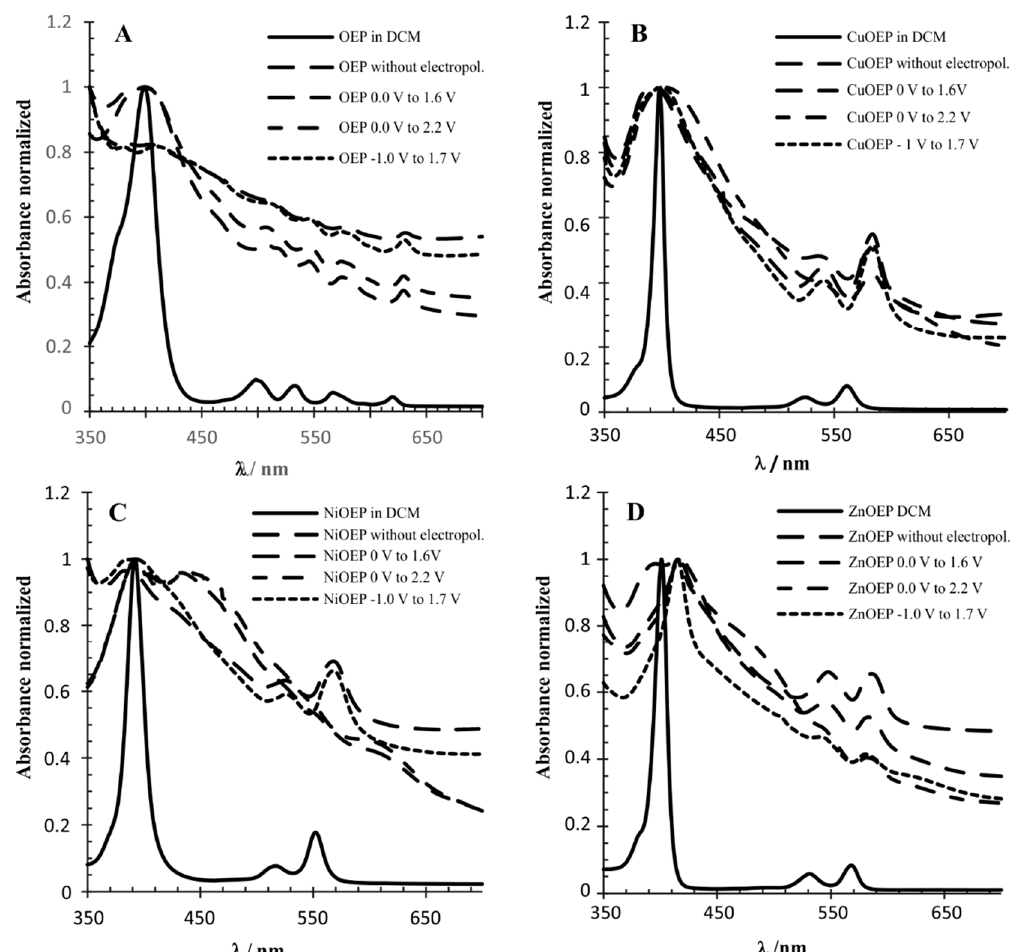
Figure 3. UV-vis normalized absorption spectra of metalloporphyrins monomers and polymers: ( A ) OEP; ( B ) CuOEP; ( C ) NiOEP; and ( D ) ZnOEP.